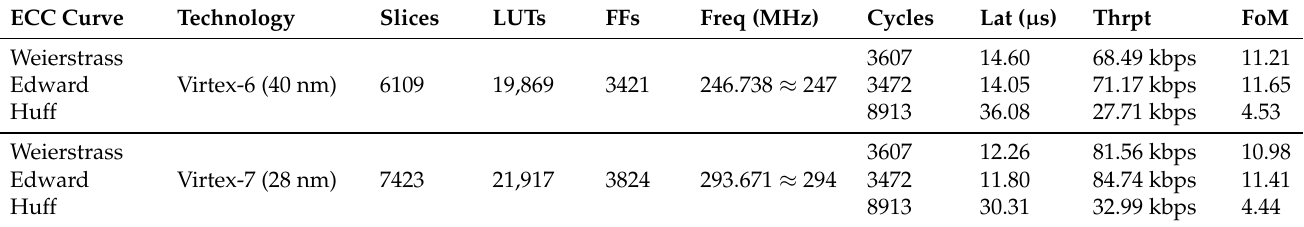
Table 3. Implementation results of our unified accelerator architecture over GF ( 2 233 ) on